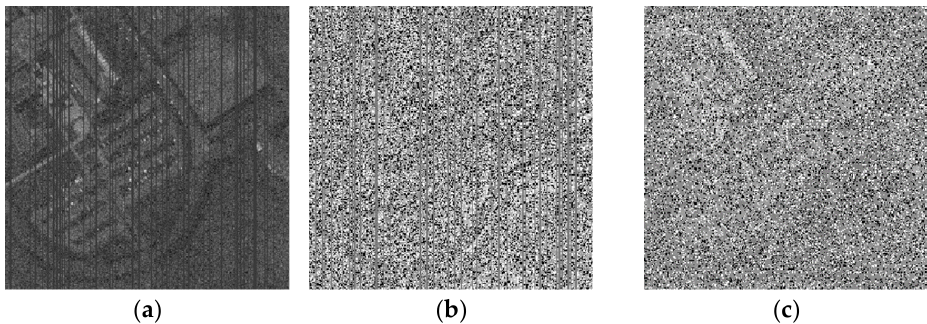
Figure 4. Noise simulation in different bands of PaviaU hyperspectral data, such as: ( a ) Gaussian noise in band 19; ( b ) Gaussian noise, salt and pepper noise, and bad lines in band 30; and ( c ) Gaussian noise and salt and pepper noise in band 77. Different bands are affected by varying degrees of noise.